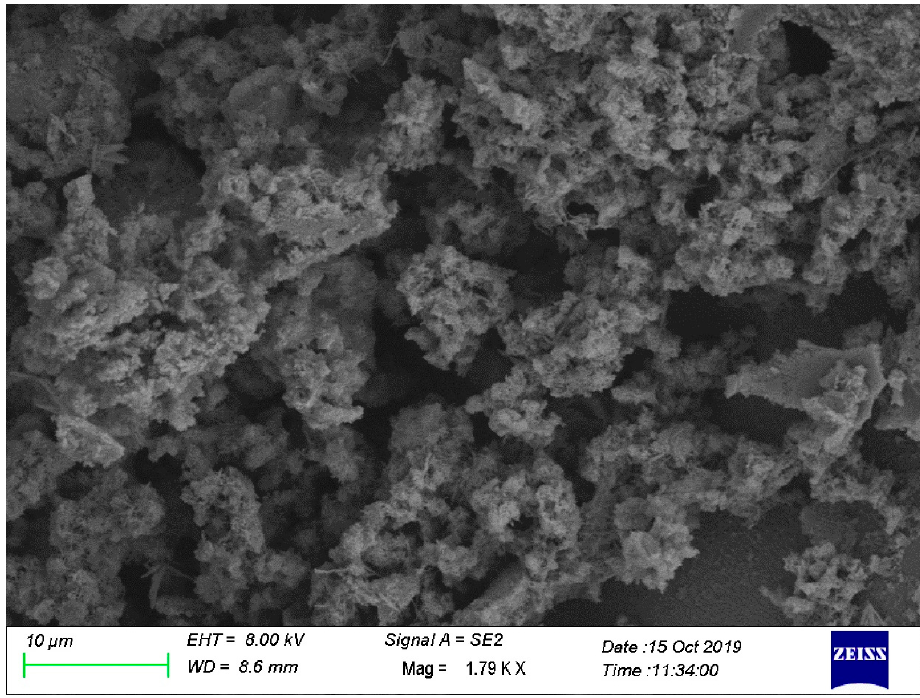
Figure 8. SEM view of N1-10 RHA cement at 56 d.